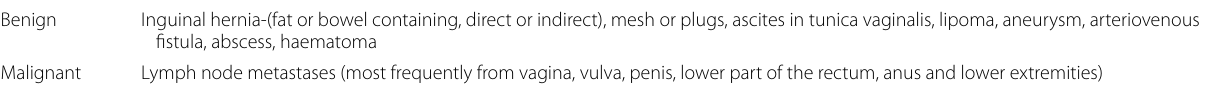
disruption can lead to haemorrhage. They normally show flow voids on T1- and T2-weighted sequences and enhance on post-contrast sequences. When thrombosed, they can be identified due to loss of normal flow void on MR (Fig. 25).